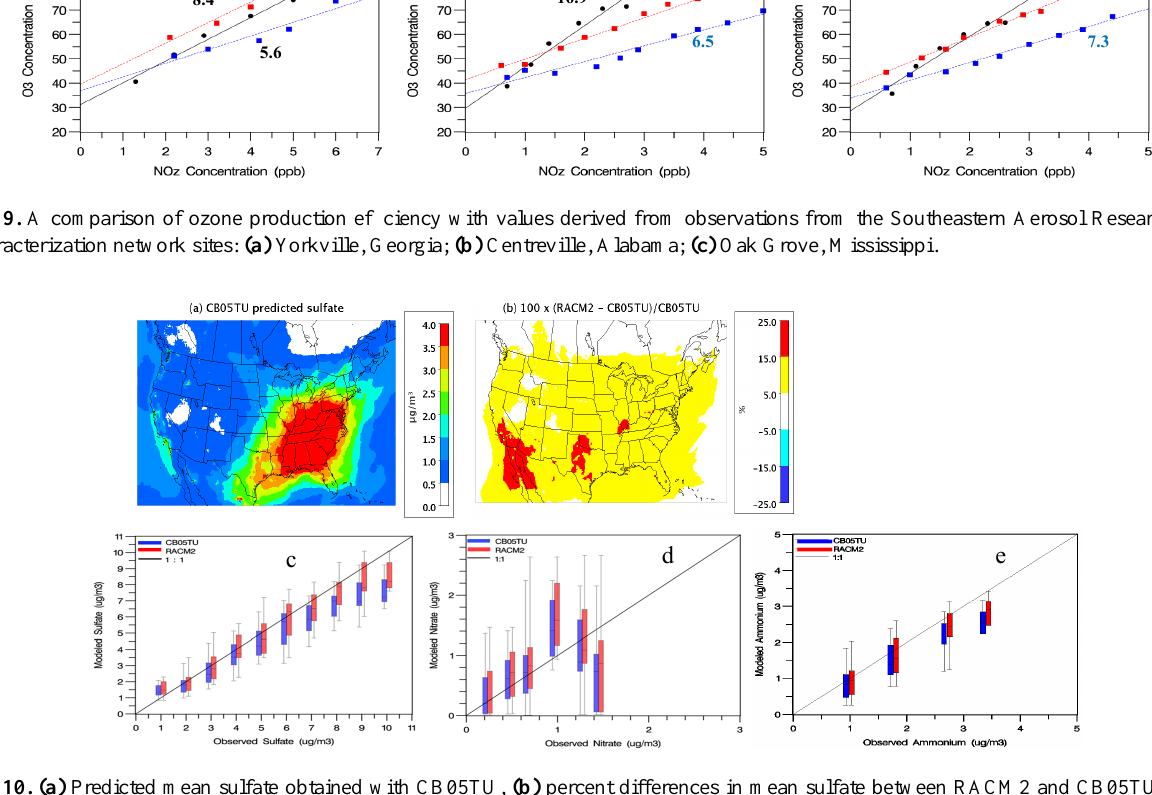
Fig. 10. (a) Predicted mean sulfate obtained with CB05TU, (b) percent differences in mean sulfate between RACM2 and CB05TU, (c) a comparison of predicted sulfate to measurements from the CASTNET sites, (d) a comparison of predicted nitrate to measurements from the CASTNET sites, (e) a comparison of predicted ammonium to measurements from the CASTNET